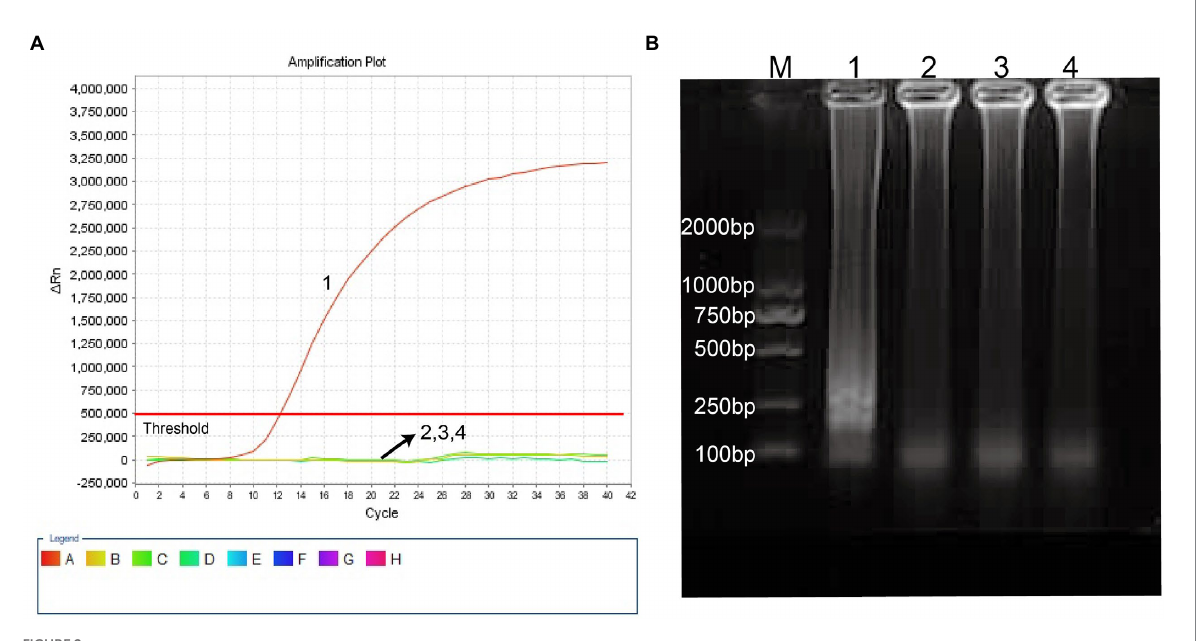
FIGURE 2 Identification and confirmation of H. influenzae- ERT-LAMP products. (A) the H. influenzae- ERT-LAMP was analyzed by means of real-time format, and the figures were obtained from FAM (labeling EFIP of P6 gene sequence) channels. Signals A1 indicate pUC57-Hi-OMP P6 DNA in FAM channels and signals A2, A3 and A4 indicate negative control ( Candida albicans ), negative control ( Escherichia coli ) and blank control (double- distilled water, DW). (B) agarose gel electrophoresis applied to H. influenzae -ERT-LAMP products; lane BM, DL 2000 bp DNA markers, lane B1 positive H. influenzae -ERT-LAMP products, lane B2, B3 and B4 indicate negative control ( Candida albicans ), negative control ( Escherichia coli ) and blank control